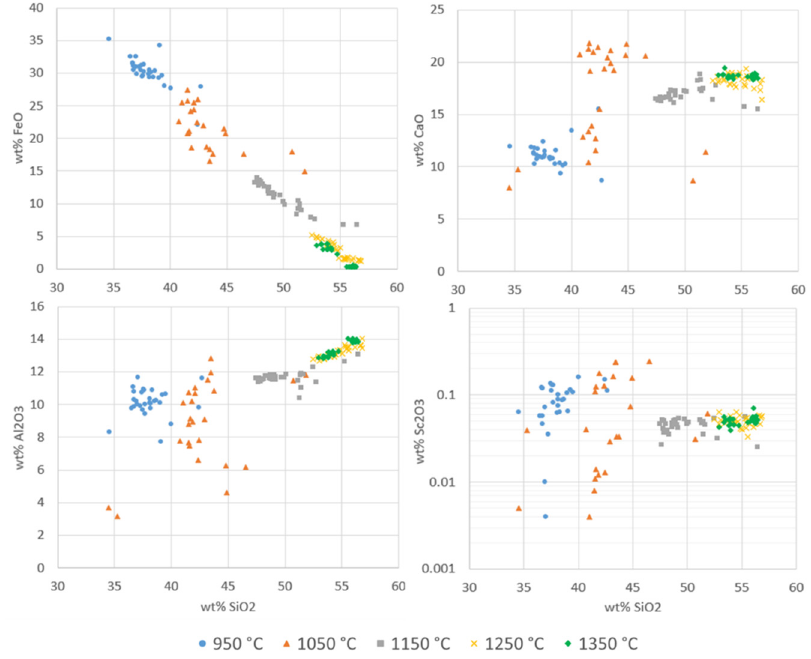
Figure 13. Binary plots of FeO, CaO, Al 2 O 3 , and Sc 2 O 3 (wt%) for amphibole relicts (blue) at 950 °C and slag at higher temperatures.